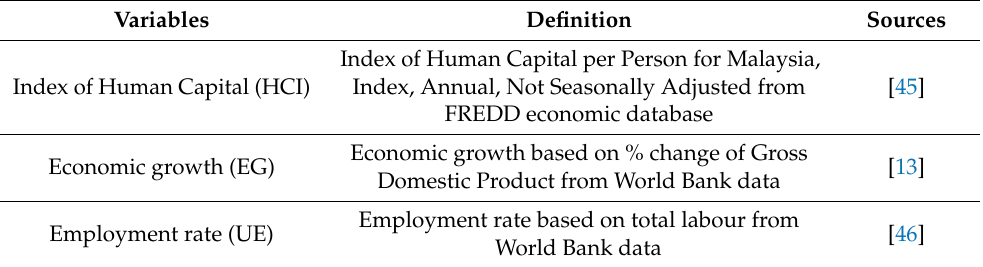
Table 1. Measurement of variable.